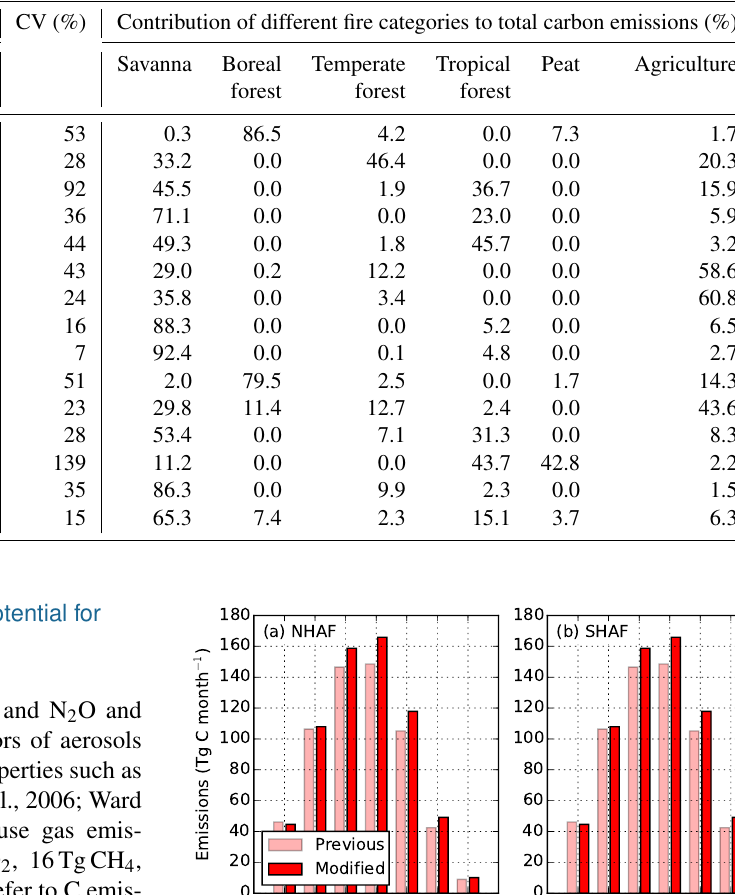
Table 3. Carbon emissions estimates and the contribution of different fire categories over the 1997–2016 study period. Region abbreviations are described in Fig. 3.